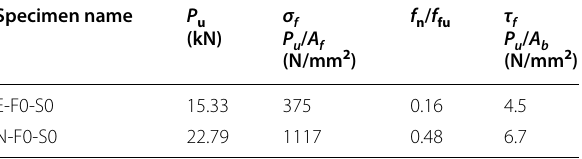
* f n is strength of specimen; the peak load was divided by sectional area of FRP. f fu is the ultimate strength of FRP, 2319 N/mm 2 which was given from tensile test, τ f is bond stress acting between FRP and concrete.